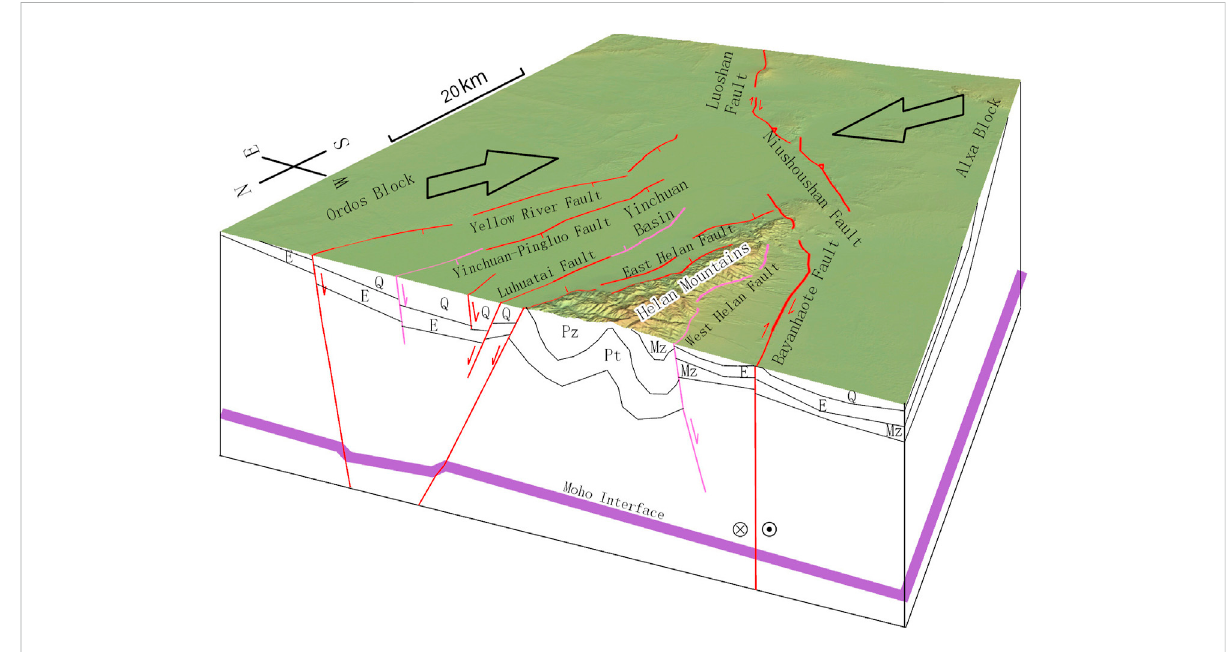
FIGURE 5 Seismotectonic model around the Helan